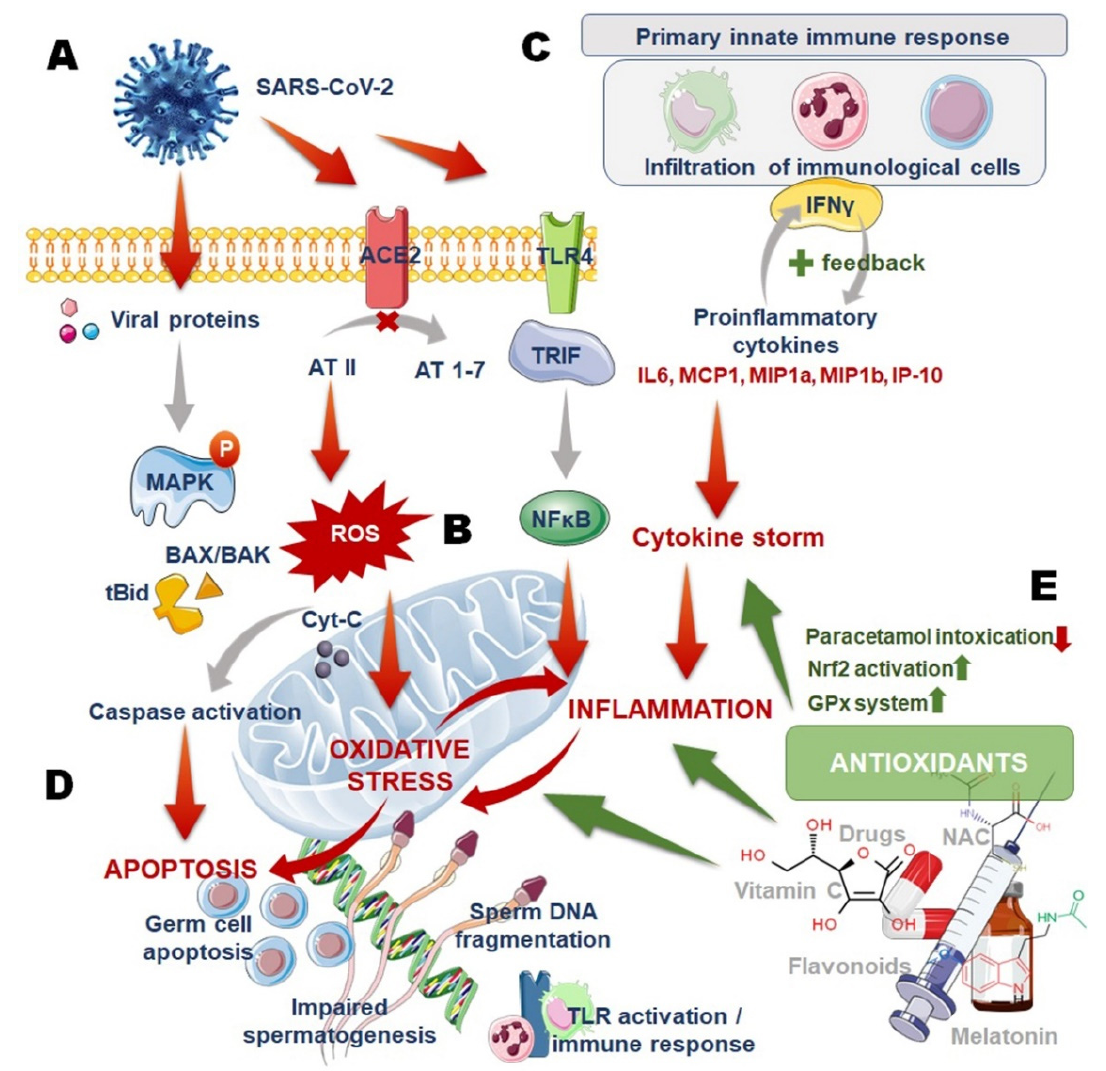
Figure 1. Mechanisms of SARS-CoV-2-mediated oxidative stress and male reproductive disruptions ( A – D ) and the roles of antioxidants in mitigating the damaging actions ( E ). As SARS-CoV-2 shares a 79% nucleotide resemblance to SARS-CoV, it may utilize a